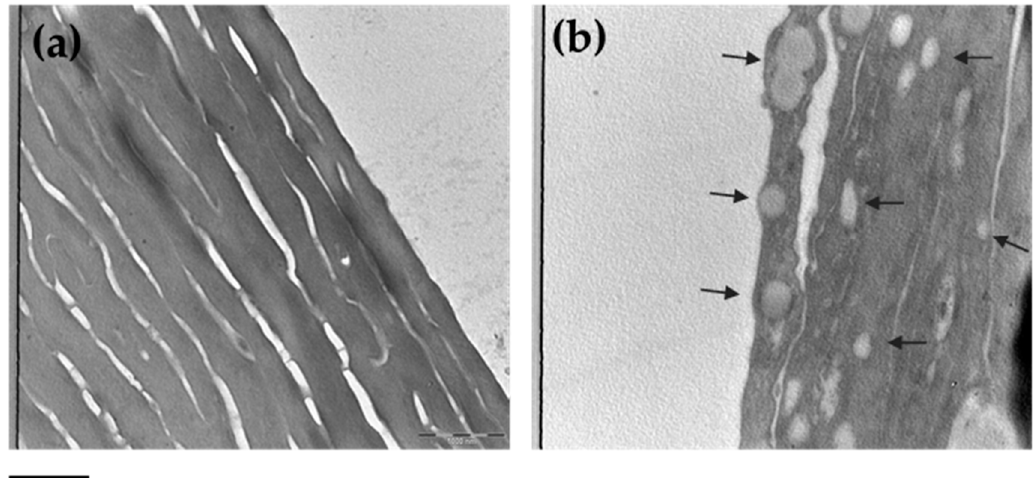
Figure 7. TEM images of control RHE ( a ) and RHE after 6 h of treatment with ETHO 0.9 ( b ). Images refer to 20K magnification. Arrows indicate the presence of ETHO 0.9 . Bar corresponds to 1000 nm.